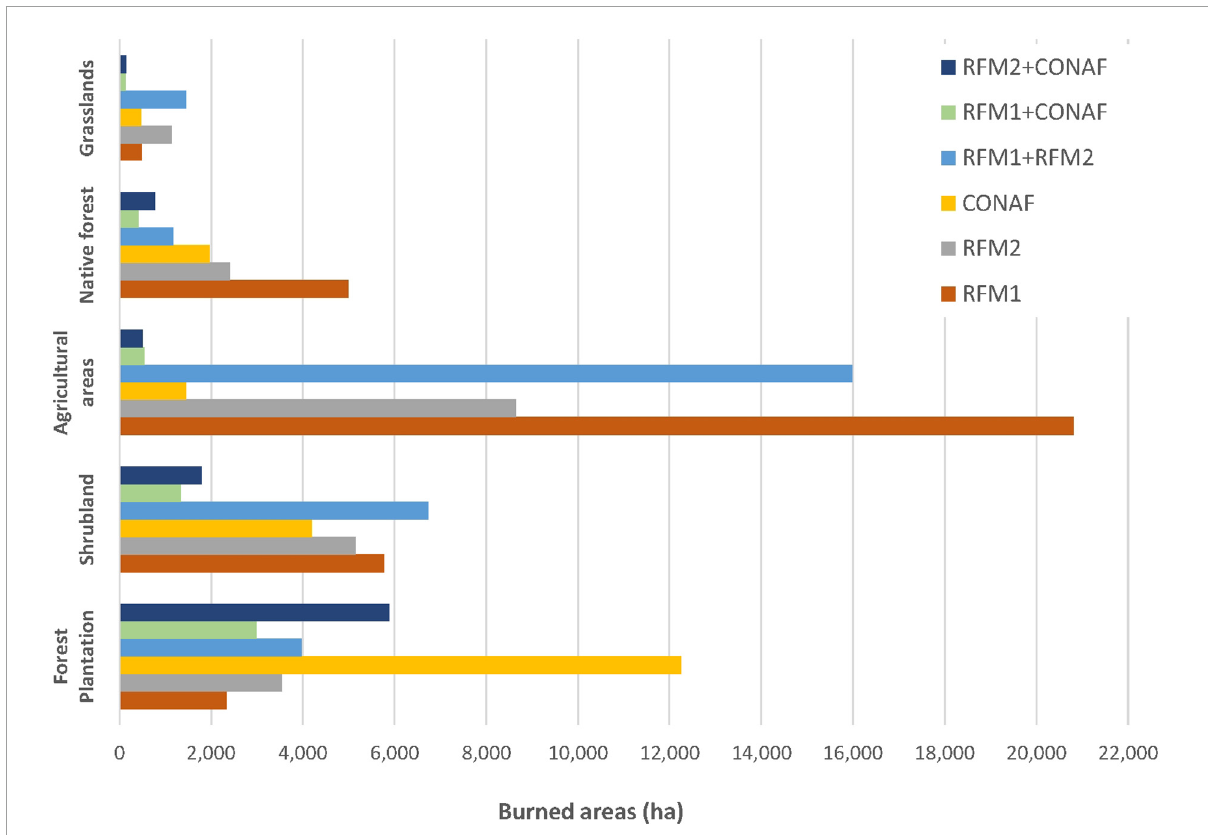
FIGURE5 Spatial distribution of the comparative analysis between the three burned area products: Official CONAF source, and RF M1 and RF M2